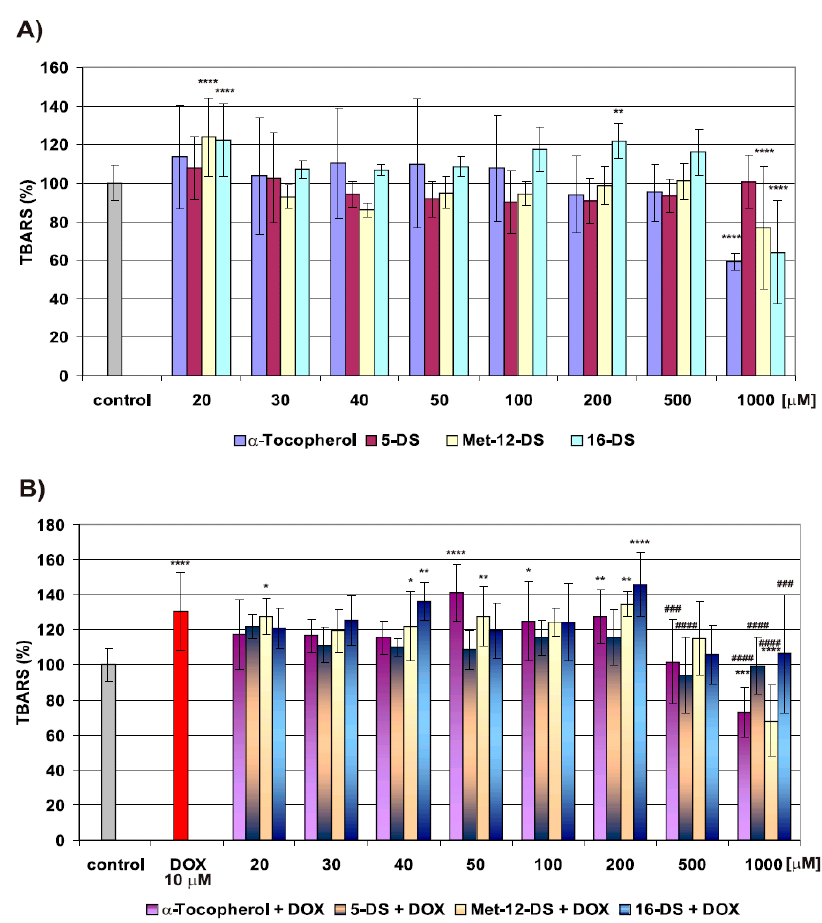
Figure 6. ( A ) The level of lipid peroxidation estimated on the basis of measurements of the amount of thiobarbituric acid-reactive substances (TBARS) in the plasma membrane of B14 cells treated with doxyl stearate nitroxides (5-DS, Met-12-DS, and 16-DS) and α -Tocopherol. The data are shown as a mean ± SD of three independent experiments, at least in three repeats each. ** p < 0.02 vs. control; **** p < 0.0001 vs. control. ( B ) The effect of α -Tocopherol and doxyl stearate nitroxides 5-DS, Met-12-DS, and 16-DS on lipid peroxidation induced in the plasma membrane of B14 cells by 10 μ M doxorubicin (DOX). The data are shown as a mean ± SD of three independent experiments, at least in three repeats each. * p < 0.05 vs. control; ** p < 0.01 vs. control; *** p < 0.001 vs. control; **** p < 0.0001 vs. control; ### p < 0.001 vs. DOX; #### p < 0.0001 vs.